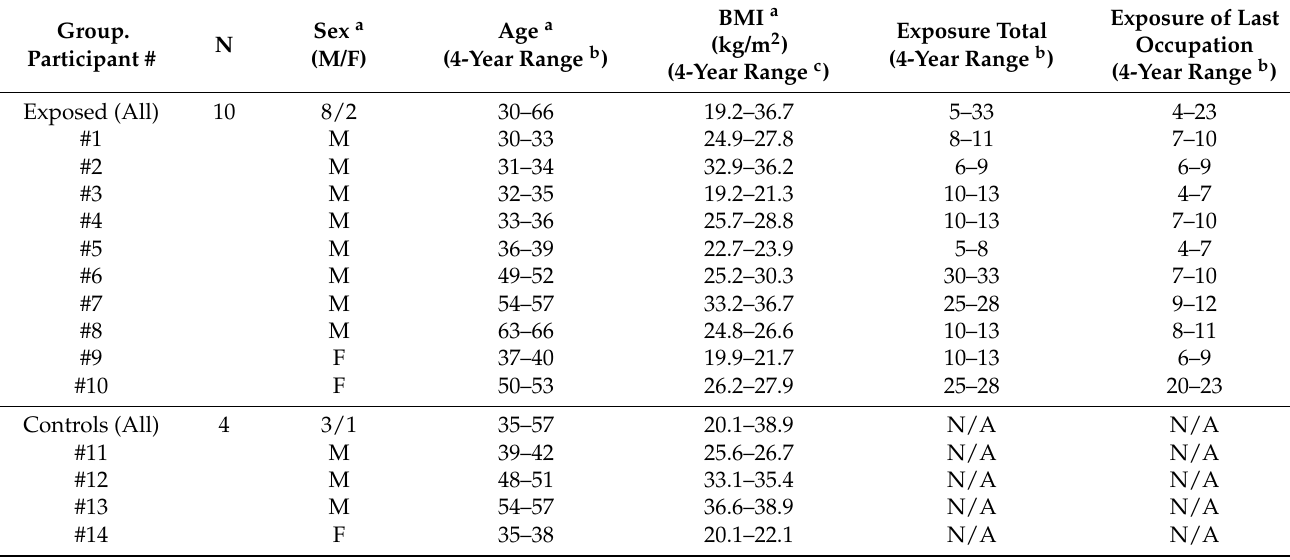
last occupation was 23 years for participant #10. The shortest NP exposure (both total and in the last occupation) was 8 and 7 years, respectively, for participant #5. Table 1. Basic characteristics of the exposed and control subjects on the group and individual levels in four consecutive years.